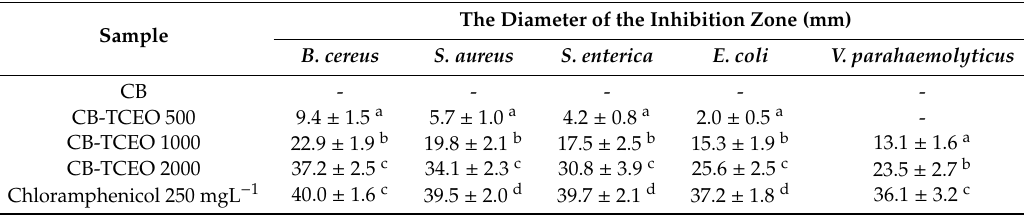
Table 2. Inhibitory activity of incorporated CB with different concentrations of the TCEO. Sample